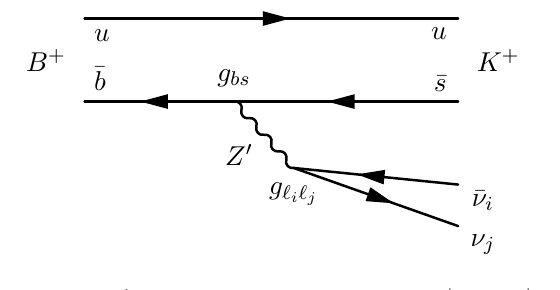
Figure 11 . Z 0 contribution to the decay B + ! K + (cid:23) (cid:22) (cid:23)